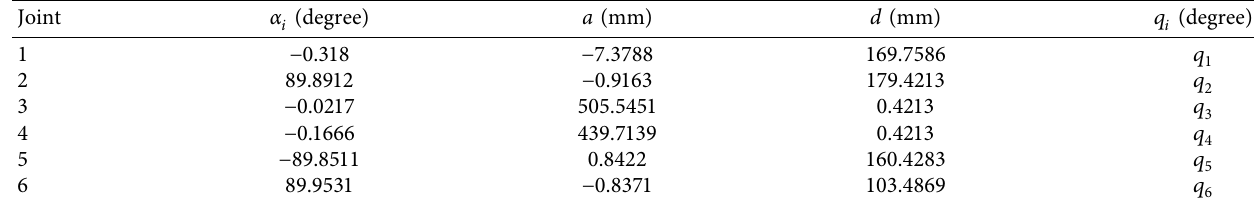
Table 2: DH table of experimental robots.